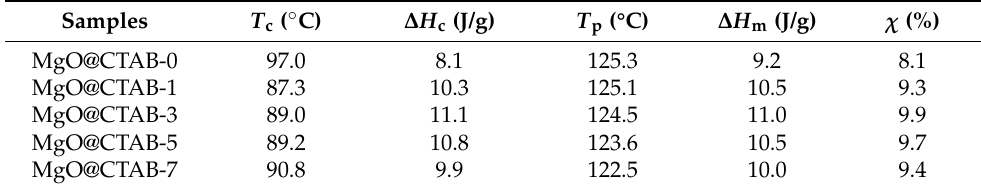
Figure 4. Differential scanning calorimetry (DSC) thermograms of PBAT/MgO@CTAB nano- composites. ( a ) First cooling, ( b ) second heating.